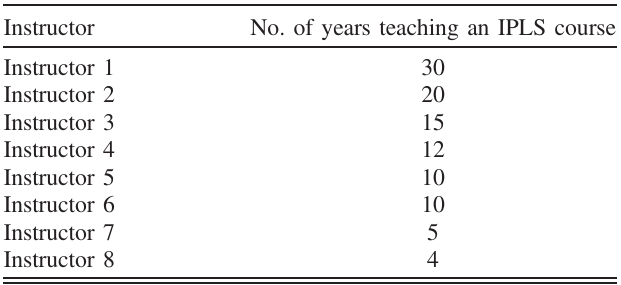
TABLE VIII. The teaching experience of the focus group participants ( N ¼ 8 ).